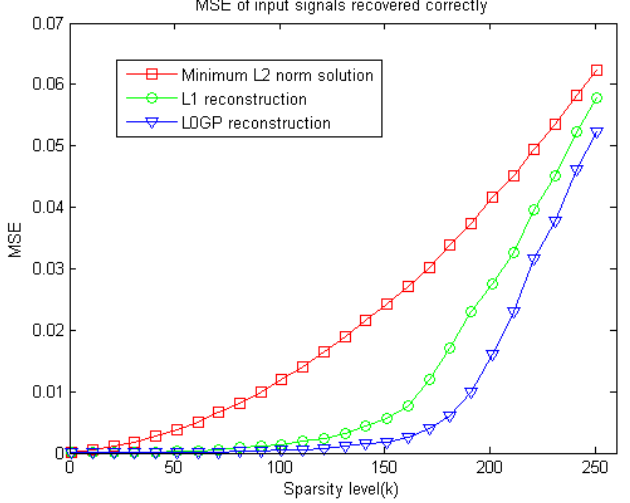
Figure 4. MSE of sparse signal with different sparsity level recovered correctly by the three different reconstruction methods.